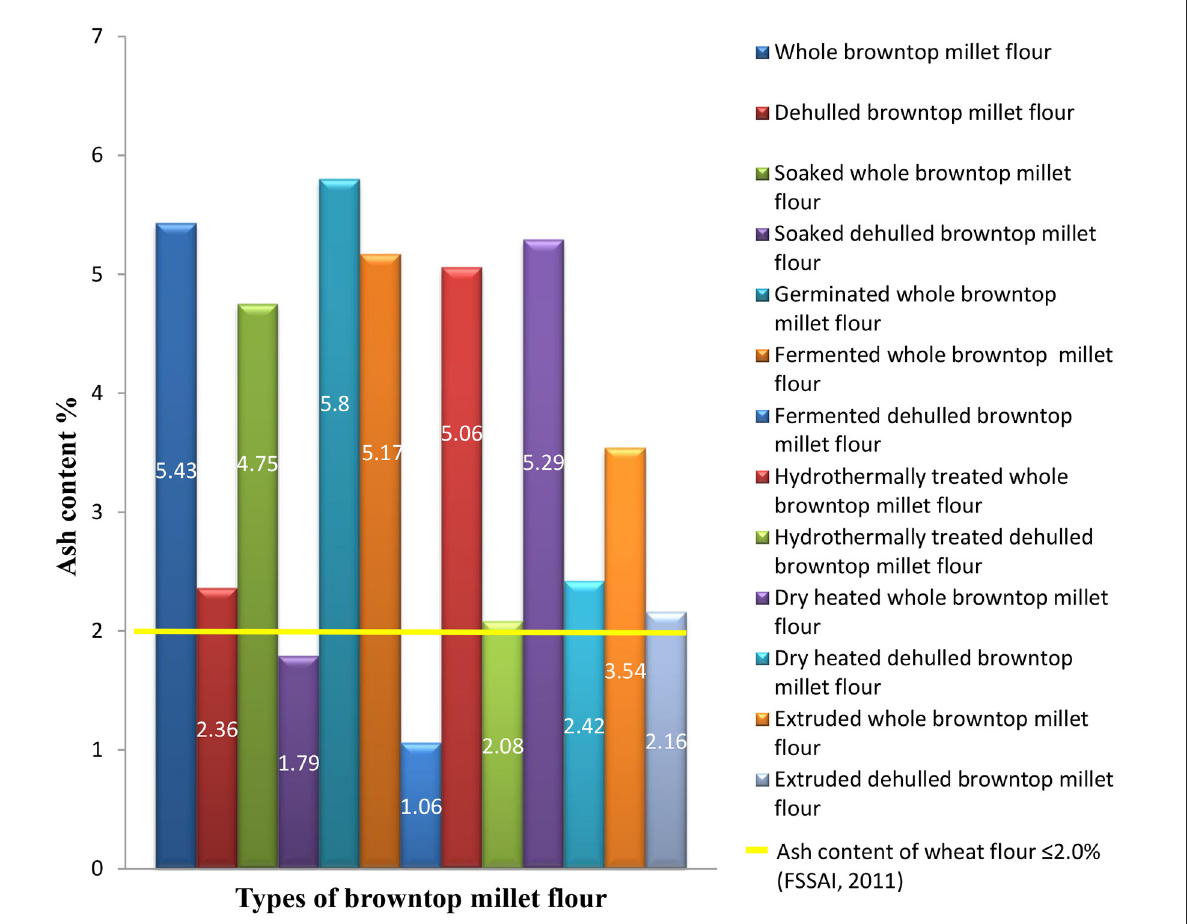
FIGURE4 Ash content of differently processed browntop millet flour. Source: Sirisha et al. (2022).